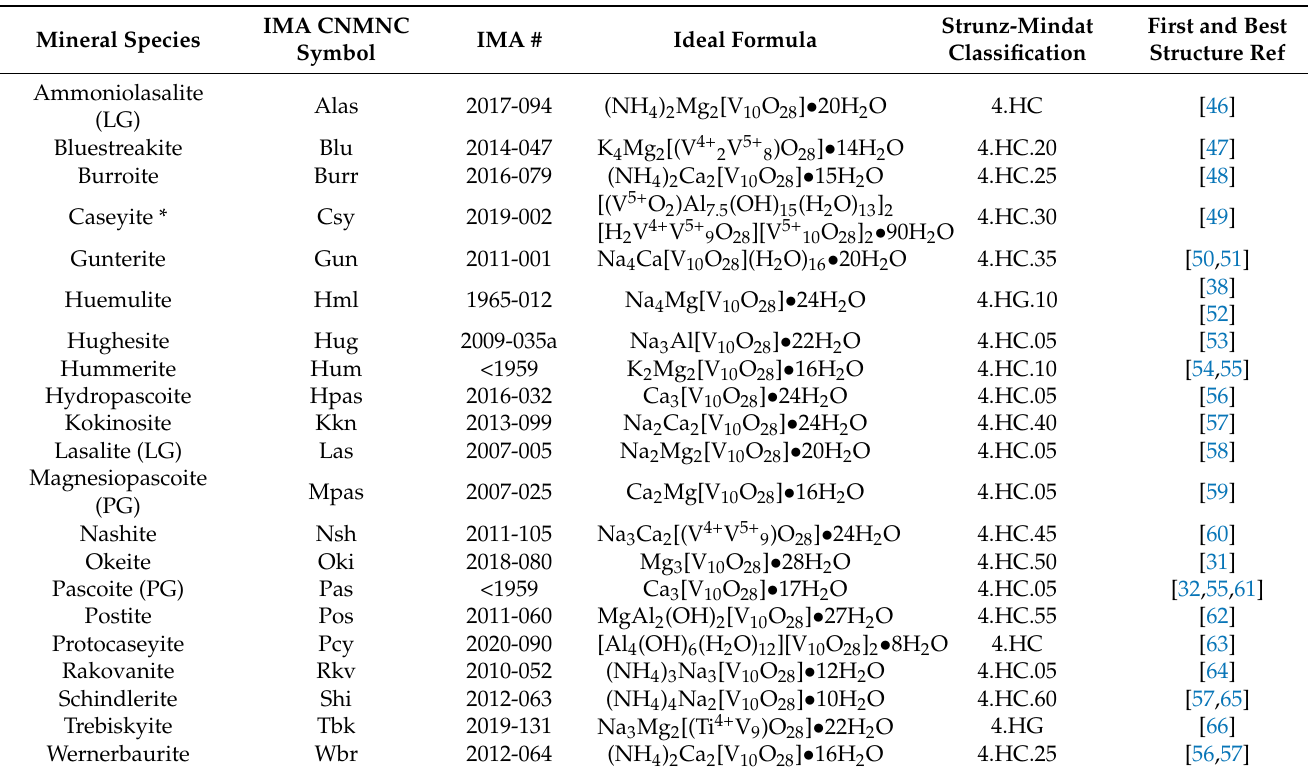
* Indicates a mineral with two formulas; # Indicate the classification IMA